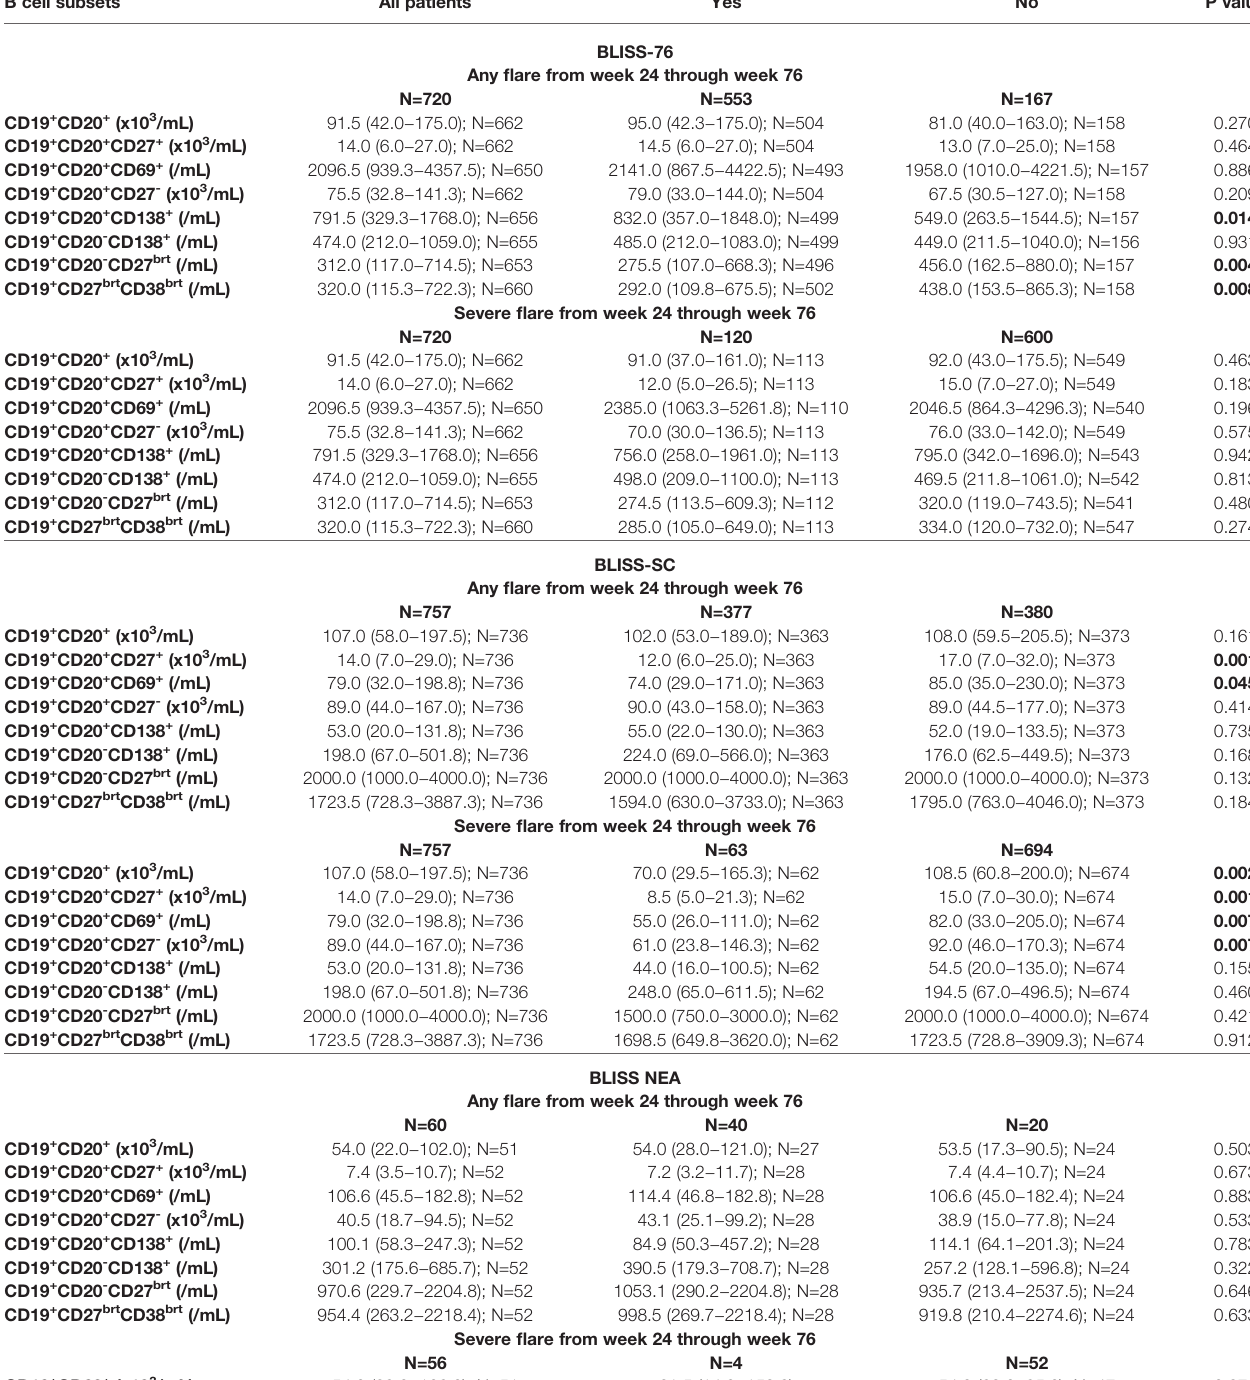
TABLE 2 | B cell subset counts at baseline in patients who developed versus patient who did not develop fl ares from week 24 through week 76 in the BLISS-76, BLISS-SC and BLISS-NEA study population. B cell